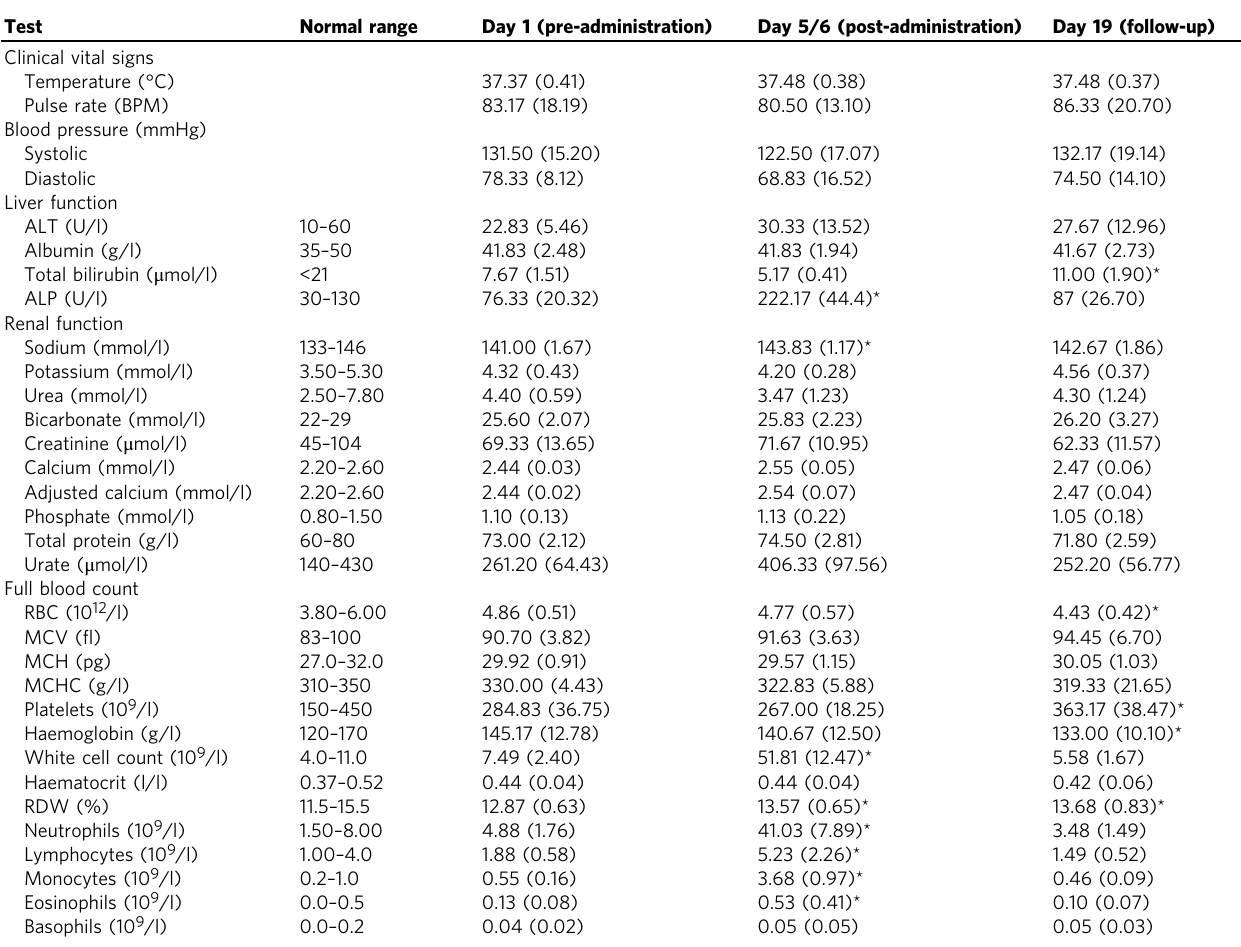
Table 2 Changes in vital signs and selected laboratory values in response to